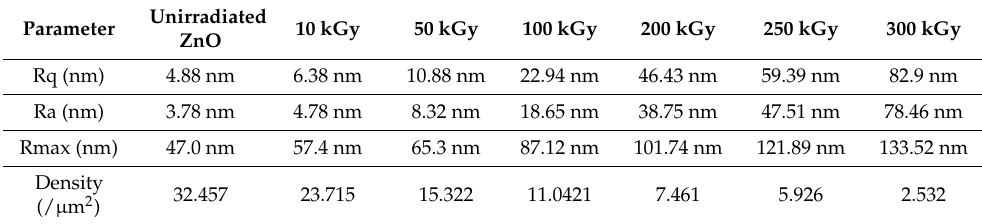
Table 1. Microstructural analysis of ZnO Roughness and particle density. Unirradiated Parameter ZnO Parameter